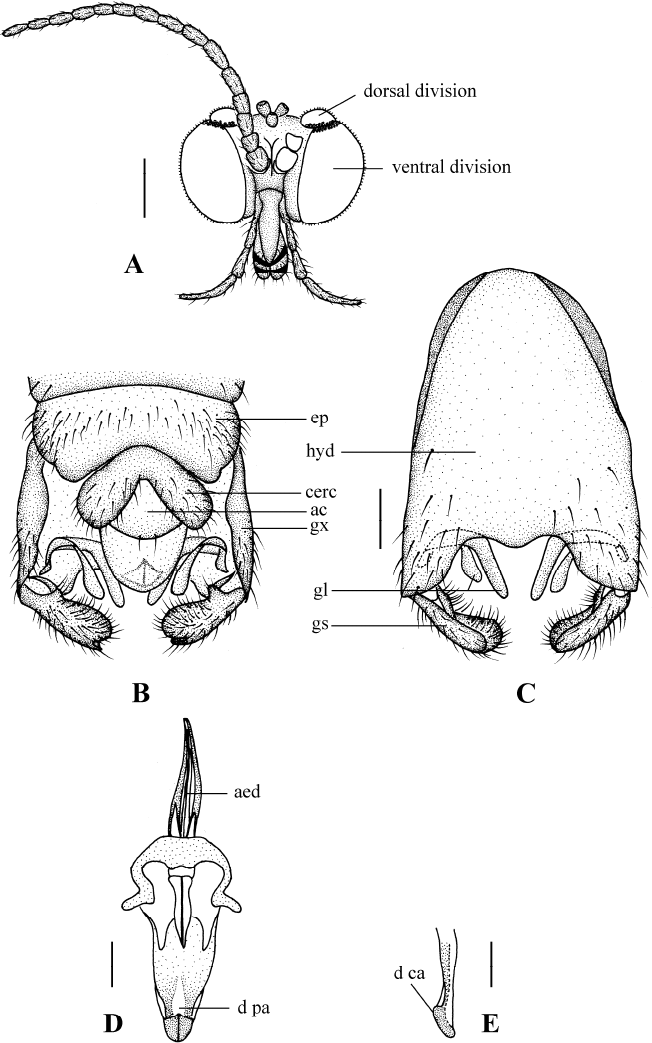
Abdomen. First tergum brown with middle area pale, 2nd to 7th terga light brown with brown strips, 8th tergum brownish yellow; 1st sternum light brown, 2nd to 7th sterna light brown with pale stripes laterally; abdomen with brownish black hairs. Male genitalia (Figure 3B–E) brown with basal 1/2 hypandrium pale. Epandrium trapeziform, posterior margin concave, with several brown hairs. Cercus triangular, inner margin slightly bulge, with several brown hairs; anal cone round with two long hairs apically. Gonostylus slightly swollen and notched apically, outer side with a wide triangular lobe folded ventrally, with hairs. Gonocoxal lobe bifurcated, outer gonocoxal lobe transparent, rod-shaped, curved medially swollen apically; inner gonocoxal lobe transparent, rod-shaped, nearly straight. Hypandrium rectangular, twice as long as wide, slightly narrow basally, posterior margin concave, with several brown hairs. Aedeagus slender, curved backward; dorsal paramere with tip arrowhead-shaped and posterior margin round; dorsal carina clearly visible, tip round and blunt.